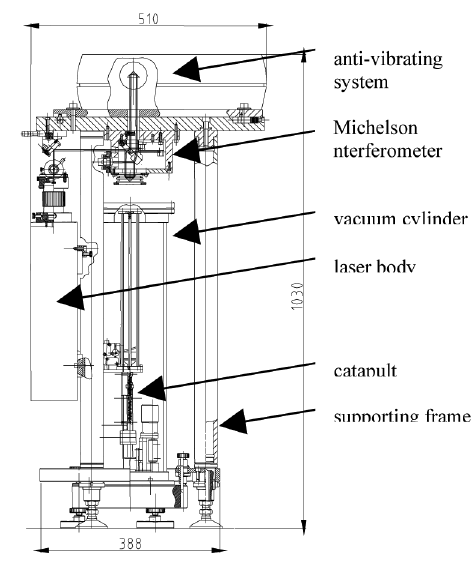
Fig. 4. Schematic drawing of the IMGC-02 ab- solute